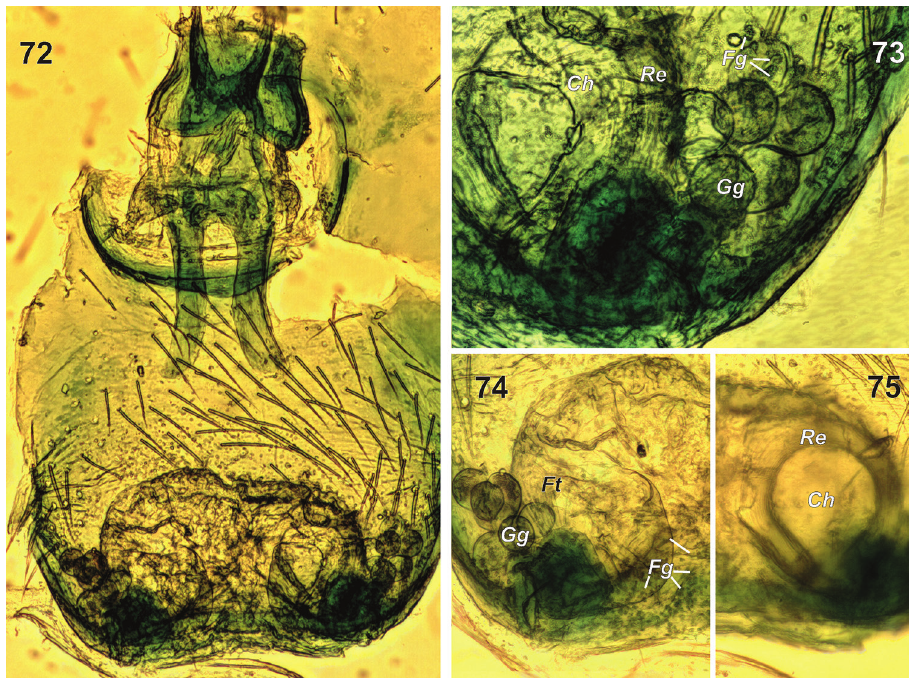
Figures 72–75. Female copulatory organs of Chedimanops rwenzorensis sp. n. 72 epigastral scutum and petiolar sclerites, ventral 73 details of vulval structures, dorsal 74 vulva, focused on grape-shaped glands, dorsal 75 right of vulva, focused on receptacle, dorsal. Abbreviations: Ch receptacular chamber; Fg fine glands; Ft fine threads; Gg grape-shaped glands; Re